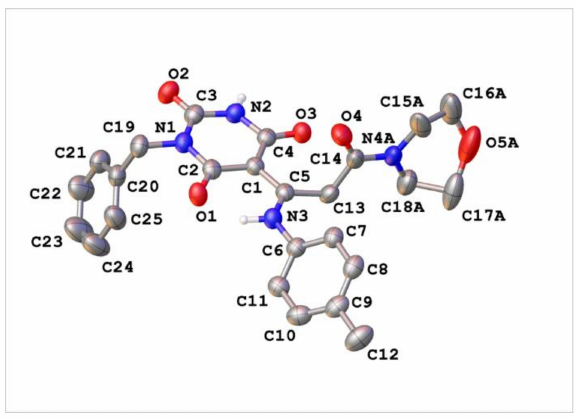
Figure A5. Crystal structure of compound 10b